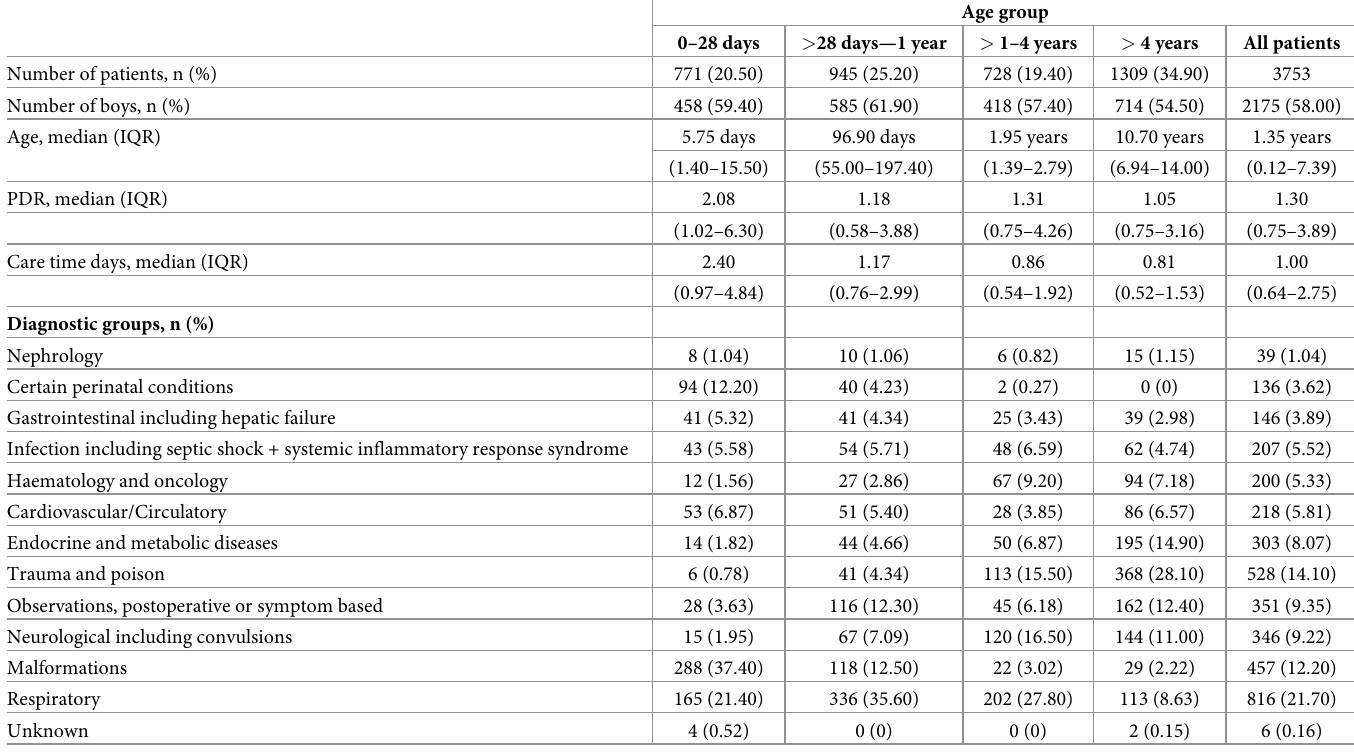
Table 1. Patient characteristics and PICU admission diagnosis by age groups: Patients with a single